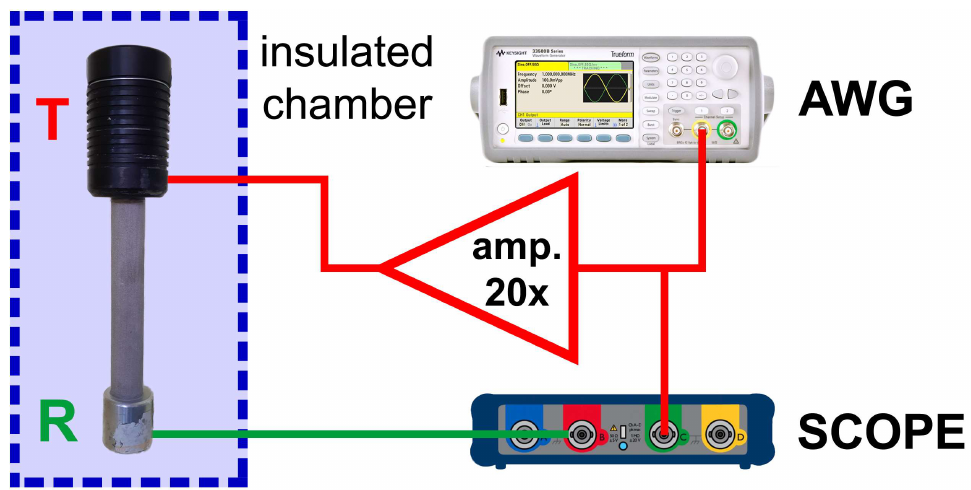
Figure 2. Schematic of the experimental set up. The sample is between the transmitter (T) and receiver (R)